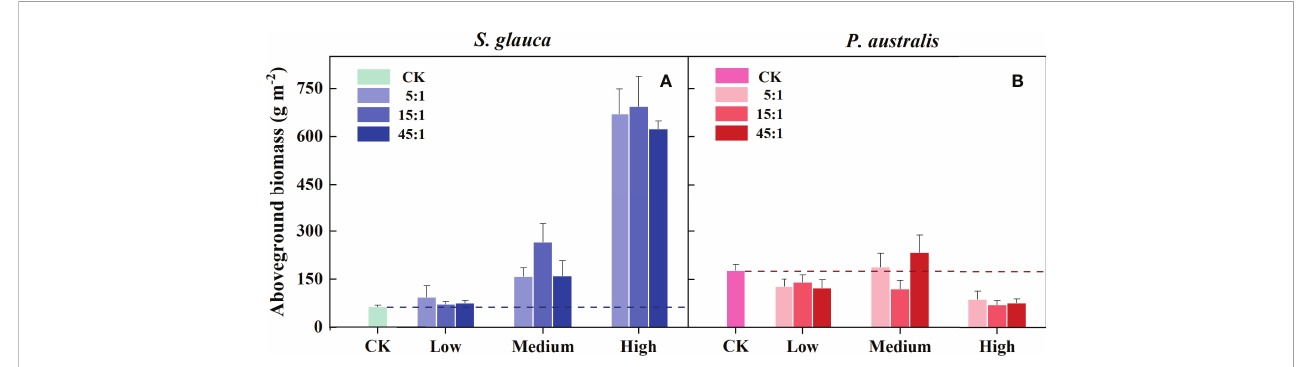
FIGURE 3 Effects of N and P addition on aboveground biomass of S. glauca (A) and P. australis (B) . CK=control. Different bars indicate the mean value (± SE) for each treatment (N and P addition, n=4; CK,